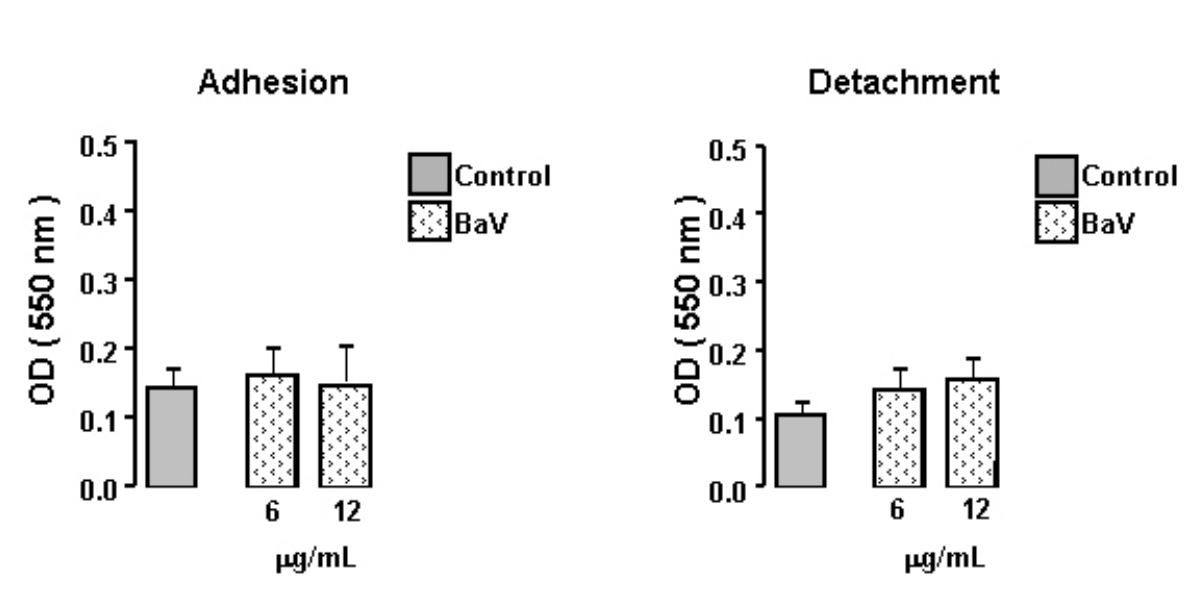
Figure 1. Effect of BaV on cell viability. Thioglycollate- elicited macrophages were collected 96 hours after intraperitoneal injection of thioglycollate. Macrophage viability was evaluated by Trypan blue exclusion; 2 x 10 5 cells were incubated with different concentrations of BaV or RPMI (control) for 60 minutes at 37°C in an atmosphere of 5% CO , after which 2 cytotoxicity was assessed by Trypan blue exclusion. Values represent the mean ± SEM from four animals. * p < 0.05 compared to controls